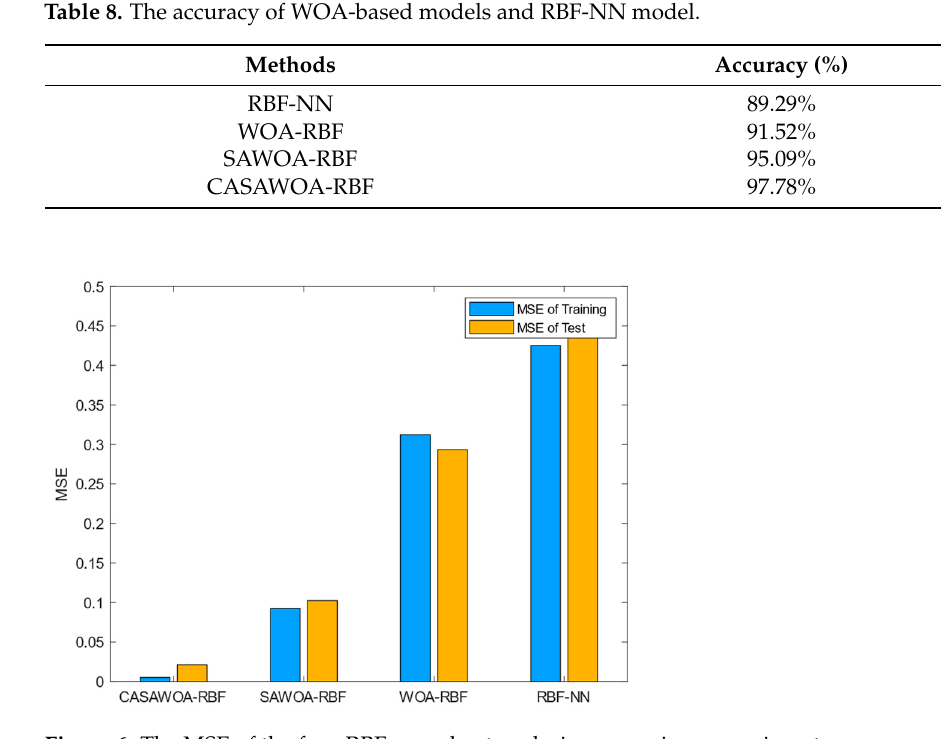
Figure 6. The MSE of the four RBF neural networks in comparison experiments.